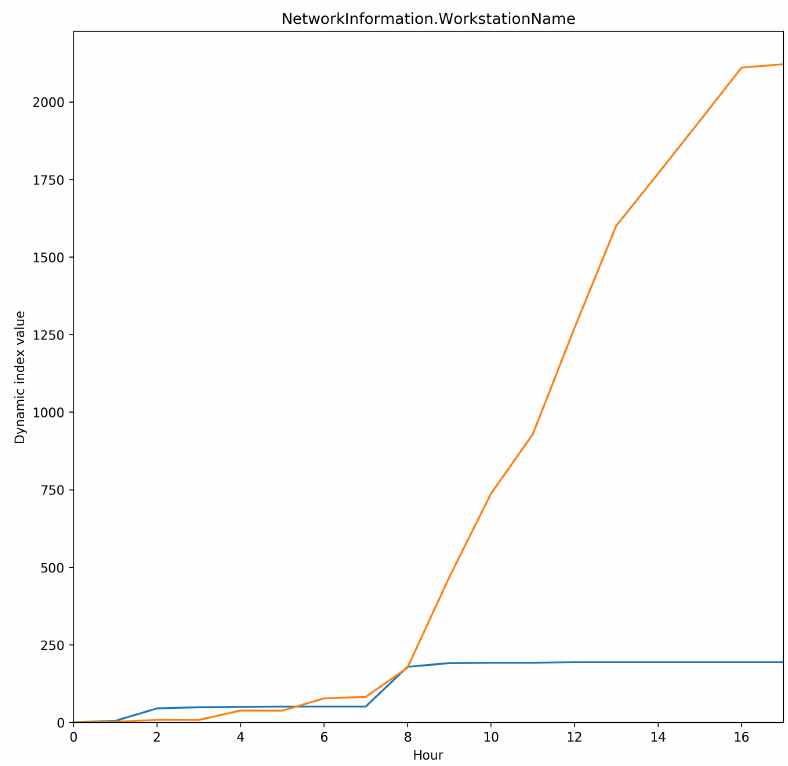
Figure 6. Dynamic indexes for the NetworkInformation.WorkstationName event property.